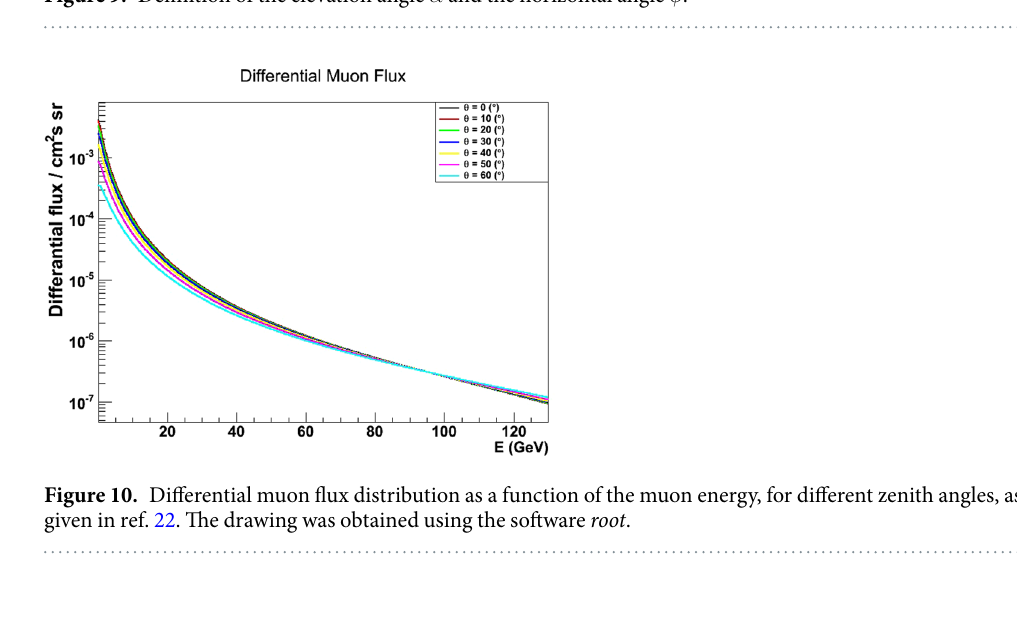
Figure 9. Definition of the elevation angle α and the horizontal angle φ .